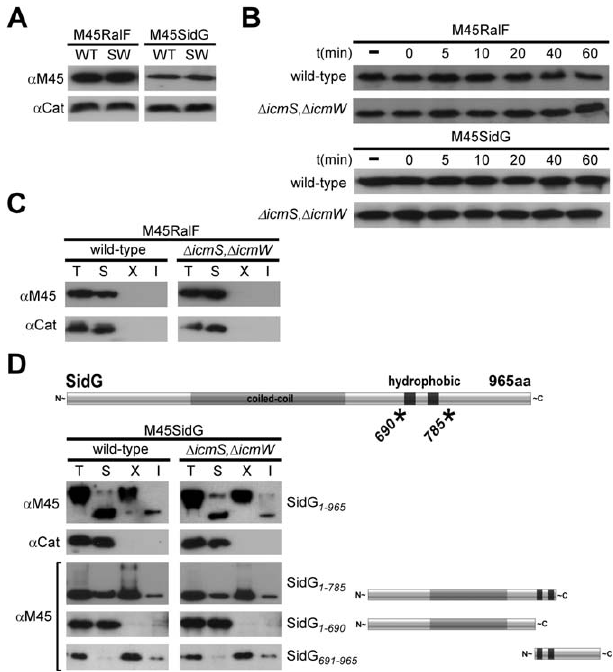
Figure 6. IcmSW Complex Does Not Influence the Stability, Solubility, or Sub-Cellular Localization of SidG (A) Immunoblots of whole-cell bacterial extracts expressing M45-SidG or M45-RalF proteins from wild-type (WT) or D icmS , D icmW (SW) probed with monoclonal antibody specific to the M45 epitope. Immunoblots for chloramphenicol acetyltransferase (Cat) are included as a load control. (B) Aliquots containing total protein from stationary phase wild-type or D icmS , D icmW L. pneumophila strains were precipitated ( (cid:2) ). Cultures were harvested, resuspended in media containing kanamycin, and allowed to incubate at 37 8 C for times indicated. Aliquots were mixed in sample buffer, resolved on SDS-PAGE, and detected with immunoblot- ting. (C) Wild-type or D icmS , D icmW mutant L. pneumophila expressing M45- RalF was cultured to stationary phase, harvested, lysed, and clarified (T). Ultracentrifugation separated a soluble (S) fraction from insoluble material. Inner membrane protein extraction with TritonX-100 (X) and subsequent ultracentrifugation separated this population from insoluble material (I). Protein contained in each fraction was detected with SDS- PAGE and immunoblotting. Immunoblots for (Cat) are included as a soluble protein control. (D) Wild-type or D icmS , D icmW mutant L. pneumophila expressing M45- SidG or indicated (*) SidG truncation proteins were cultured and subjected to sub-cellular fractionation as in (C). Protein contained in each fraction was detected with SDS-PAGE and immunoblotting. Immuno- blots for (Cat) are included as a soluble protein control.